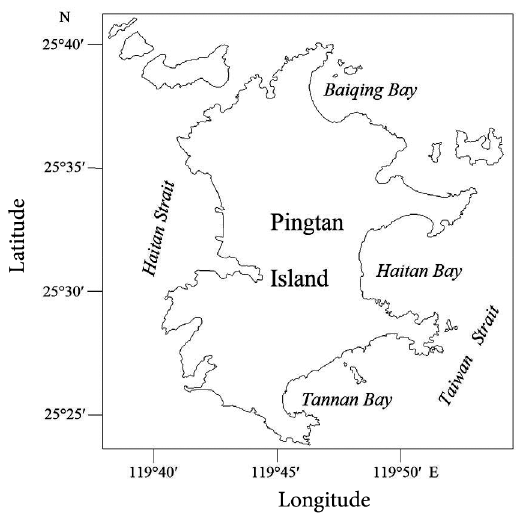
Figure 1. Geographic location of Pingtan